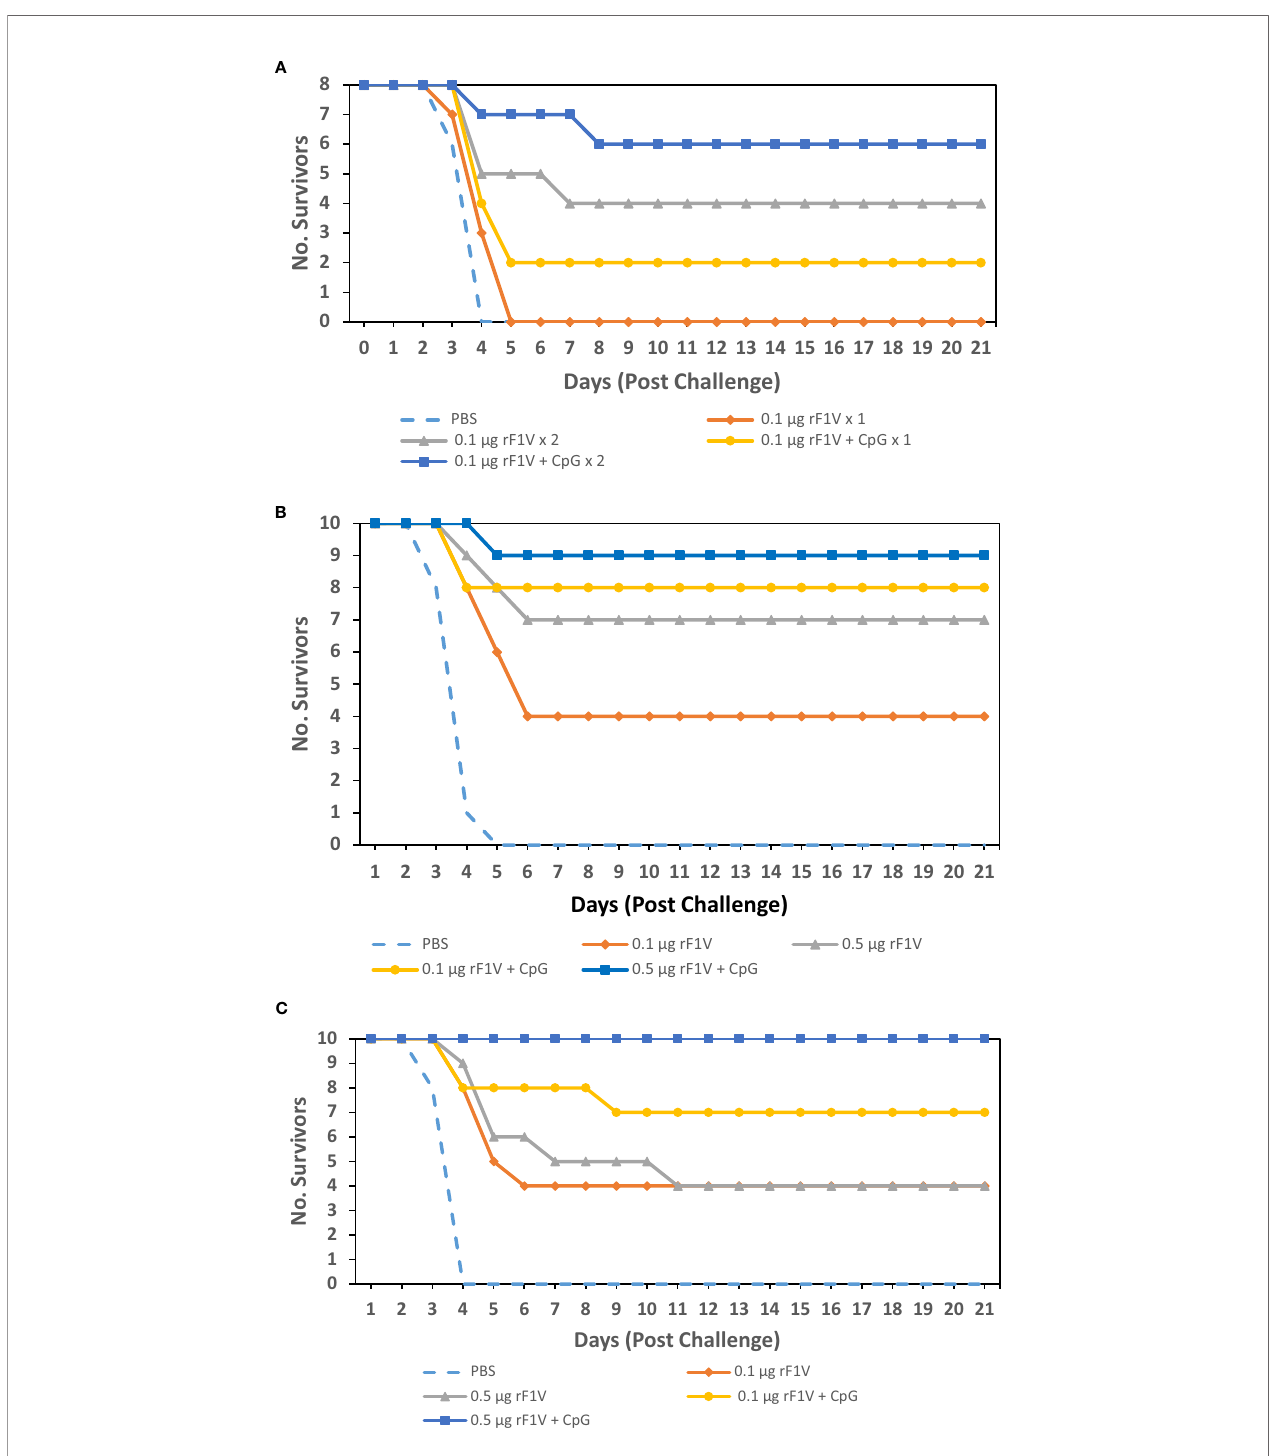
FIGURE 5 | Adjuvanation of rF1V with CpG improves protection against Y. pestis C12 aerosol challenge. (A) BALB/c mice were vaccinated with either one subcutaneous dose (x 1) or 2 subcutaneous doses (x 2) that were 3 weeks apart, with mock/PBS, 0.1 µg or 0.5 µg of rF1V with or without 5 µg CpG (n=8). At 29 days post vaccination, BALB/c mice were exposed to 4.81x10 5 aerosolized CFU (approximately 6 LD 50 equivalents) of Y. pestis C12. (B) BALB/c mice were vaccinated with 2 subcutaneous doses that were 3 weeks apart (n=10). At 29 days post vaccination, BALB/c mice were exposed to 6.51x10 5 aerosolized CFU (approximately 8 LD 50 equivalents) of Y. pestis C12. (C) BALB/c mice were vaccinated with 2 subcutaneous doses that were 3 weeks apart (n=10). At 43 days post vaccination, BALB/c mice were exposed to 2.25 x10 5 aerosolized CFU (approximately 3 LD 50 equivalents) of Y. pestis C12. Survival was monitored for 21 days post